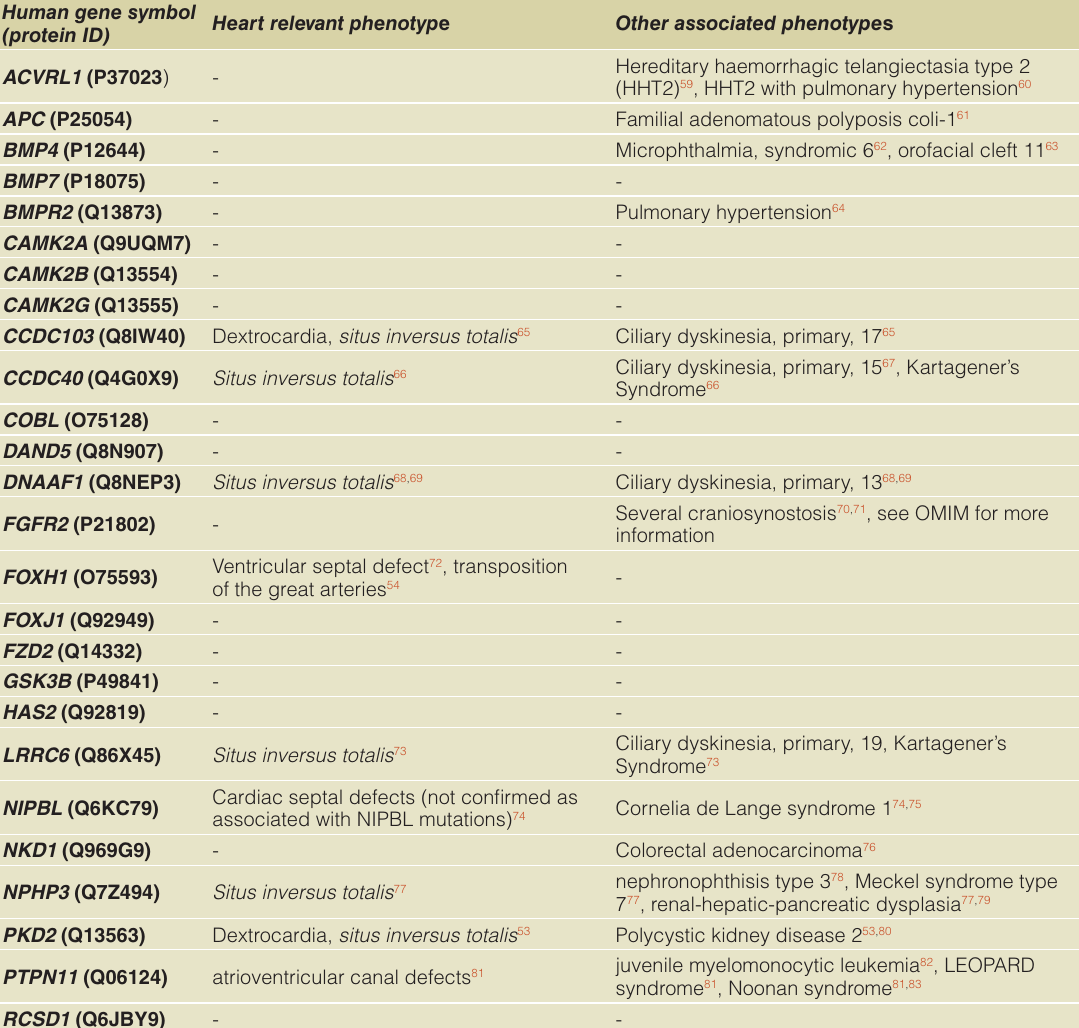
Table 3. Diseases associated with the human ‘jogging ortholog’ genes. The associated diseases are described in the listed publications. Human gene symbol (protein